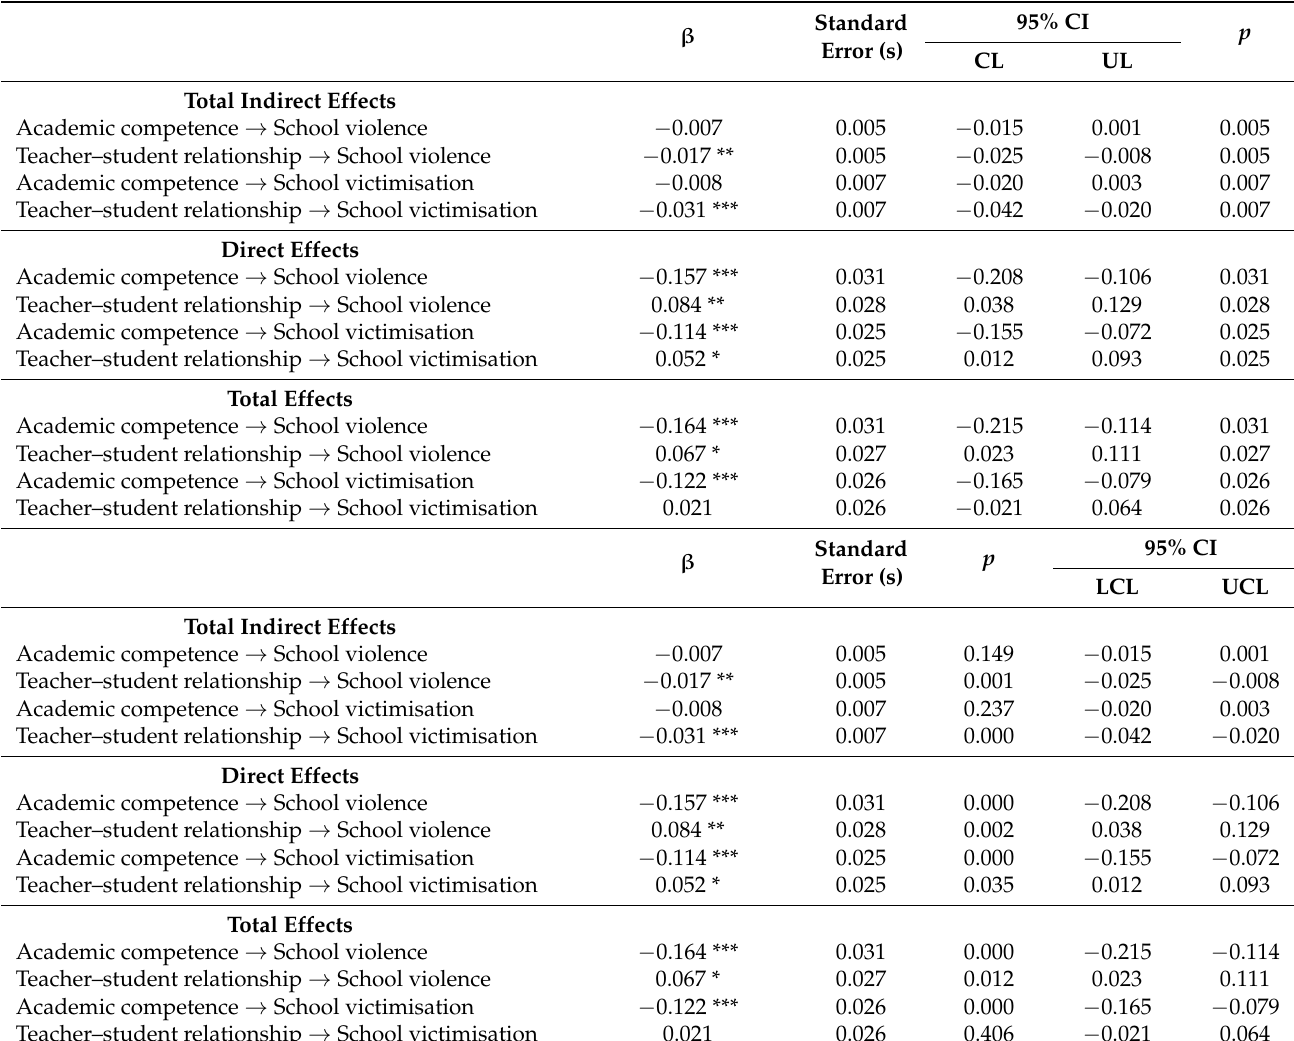
Table 4. Indirect, direct, and total effects with their confidence